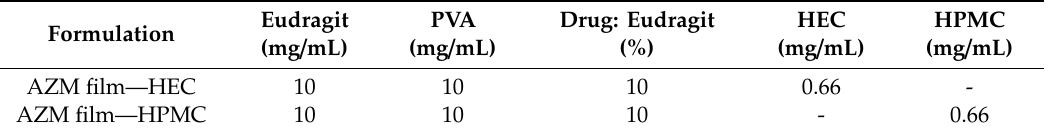
Table 2. Preparative characteristics of the ocular inserts of azithromycin. HEC: hydroxyethyl cellulose and HPMC: hydroxypropyl